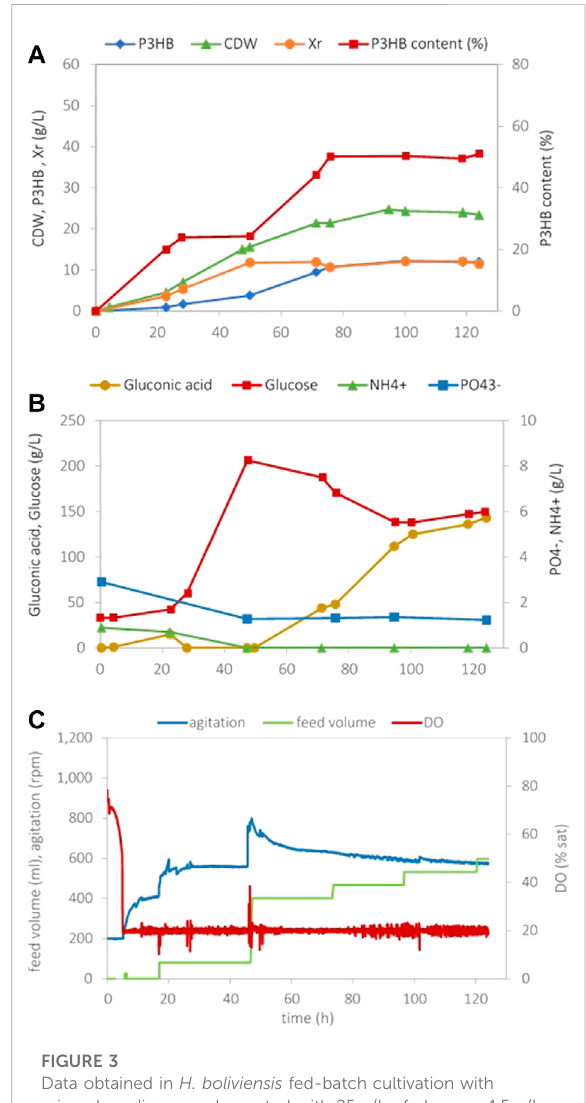
FIGURE 3 Data obtained in H. boliviensis fed-batch cultivation with mineral medium supplemented with 25 g/L of glucose, 4.5 g/L K 2 HPO 4 ,and3.0 g/LNH 4 ClatpH7.5and20%satofDO.Asolution containing 600 g/L of glucose was used as feed. (A) Cell dry weight, P3HB, the residual cell concentration, and the P3HB cell content during the cultivation, (B) glucose, gluconic acid, phosphate, and ammonia concentrations, and (C) data acquired automatically during the